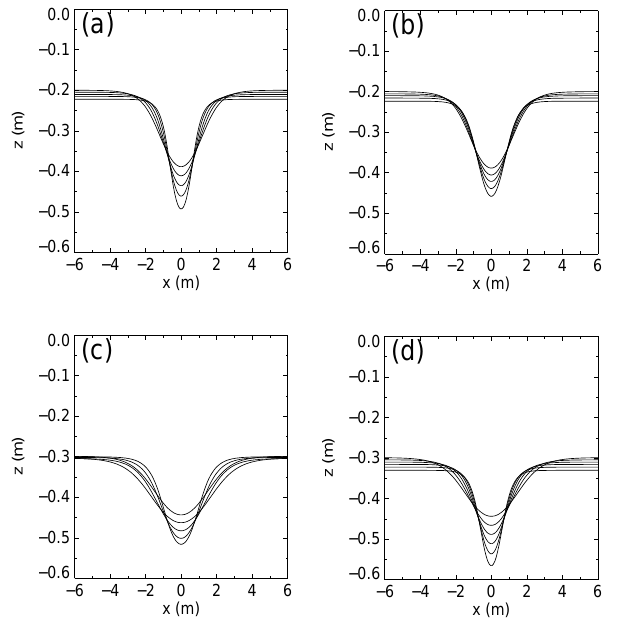
Fig. 3. Isopycnals undergoing maximum displacement for waves with ¯ E a = 10Jm − 1 . Stratifications and currents as in Fig. 1. As U m decreases from 0 the waves get narrower and the maximum isopycnal displacement increases. The isopycnal undergoing maxi- mum displacements shifts downward except for the cases in (c) , for which it initially shifts downward and then upwards.